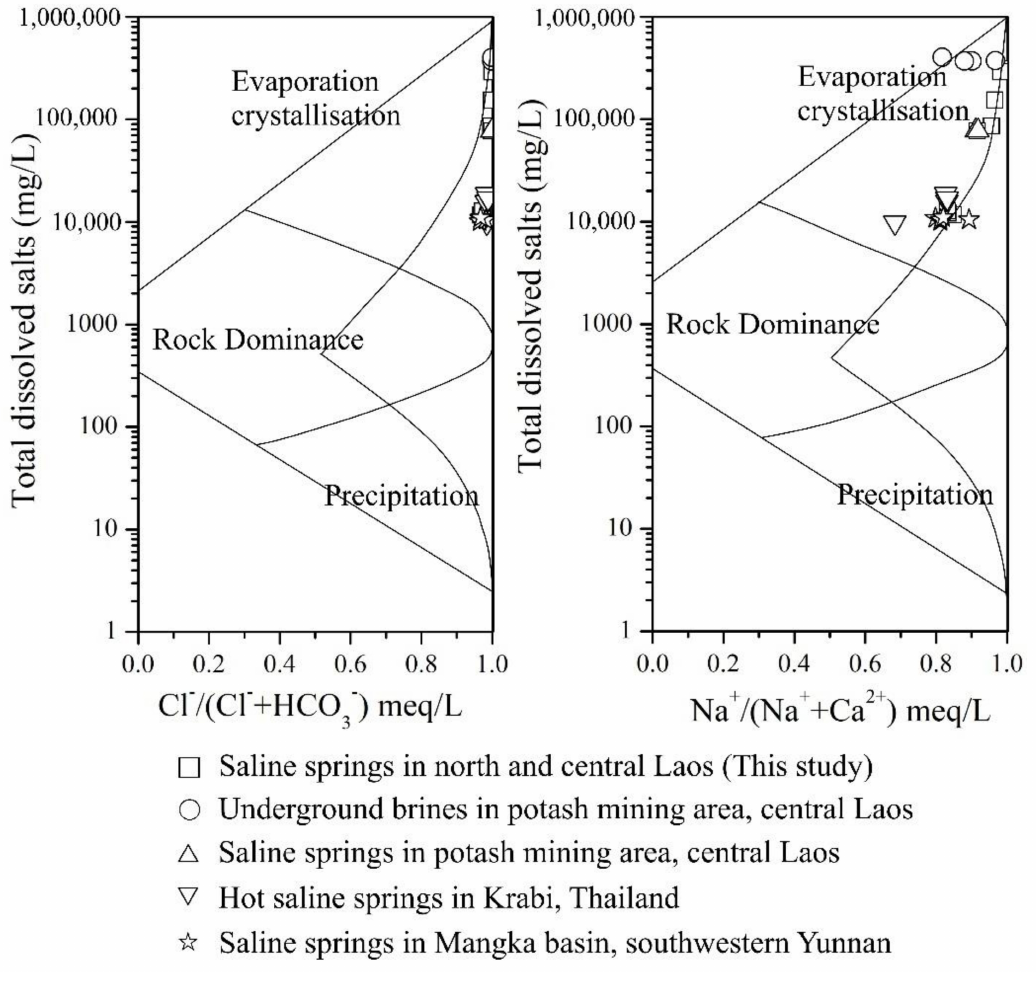
Figure 4. Gibbs diagram of the saline springs in north and central Laos, the comparison area date from